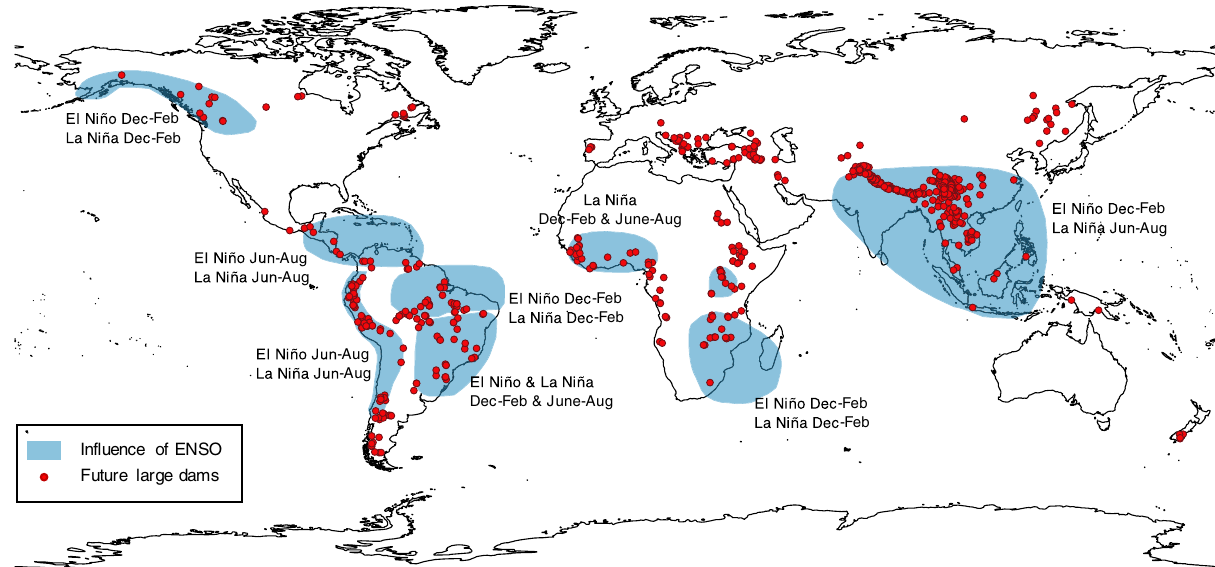
Fig. 5 Future dams overlap regions with a strong ENSO in fl uence. The red points indicate the locations of medium-to-large future hydropower reservoirs and dams, extracted from the FHReD database 1 . Dam height is generally employed to discern between small, medium, and large dams, but in the absence of this information, we consider as medium-to-large the hydropower projects with an installed capacity grater than 150 MW, retaining a total of 642 dams of the over 3700 reported in the database. A blue shade highlights the regions of the globe that are most affected by El Niño and La Niña oscillations 76 . Over 70% of medium-to-large future dams are located in areas affected by the ENSO